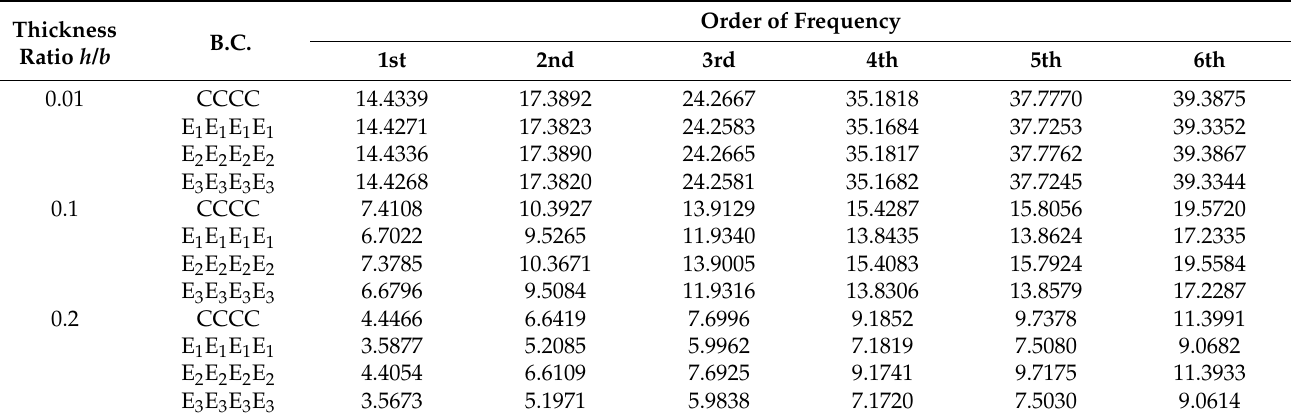
Table 11. The nondimensional frequency Ω for composite laminates with elastic boundary conditions.